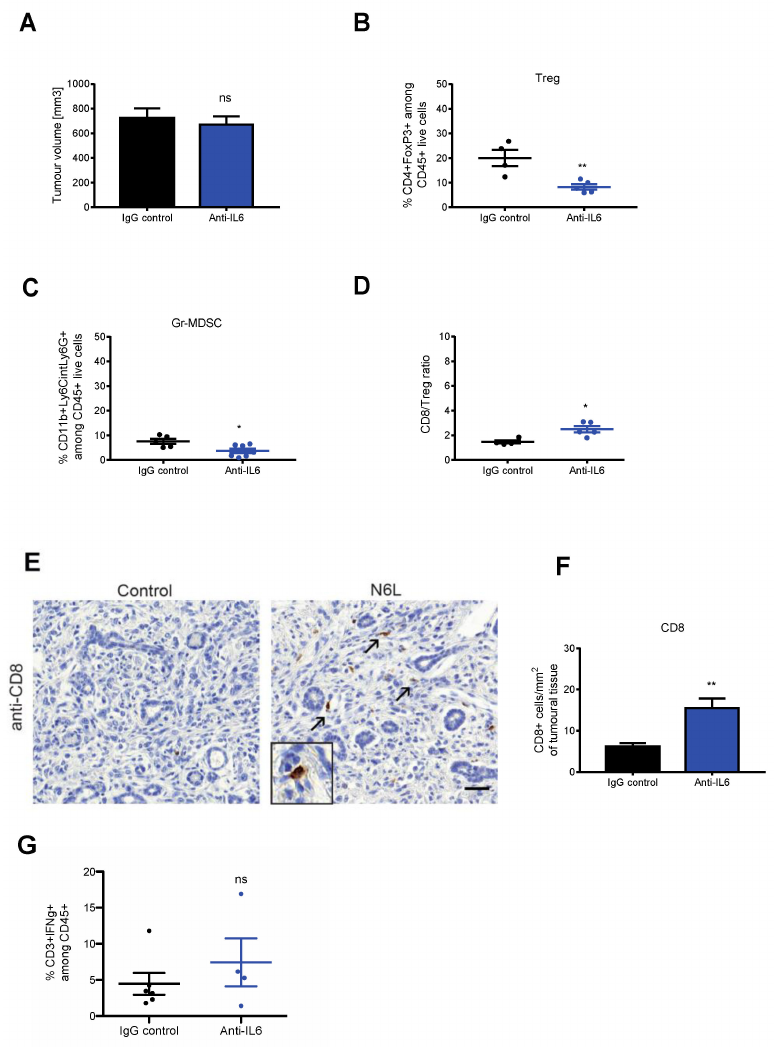
Figure 6. Anti-IL-6 antibody mimics N6L effects on PDAC immune microenvironment. mPDAC tumours were generated as in Figure 2 and treated with anti-IL-6 blocking antibody or IgG control antibody for three weeks, three times per week, by i.p. injection. Mice were sacrificed 21 days after the treatments. ( A ) Tumour volumes were measured as in Figure 2, and graphs show a representative experiment (from two independent experiments). ( B – D ) Immune cell populations in tumour tissues were analysed by flow cytometry as in Figure 2. Tregs and PMN-MDSC were analysed, and the results are plotted as the fold change of the % of ( B ) CD45 + CD4 + FoxP3 + cells and ( C ) CD11b + Ly6G + Ly6C low cells in N6L-treated tumours relative to control tumours. ( D ) Fold change of the CD8/Treg ratio